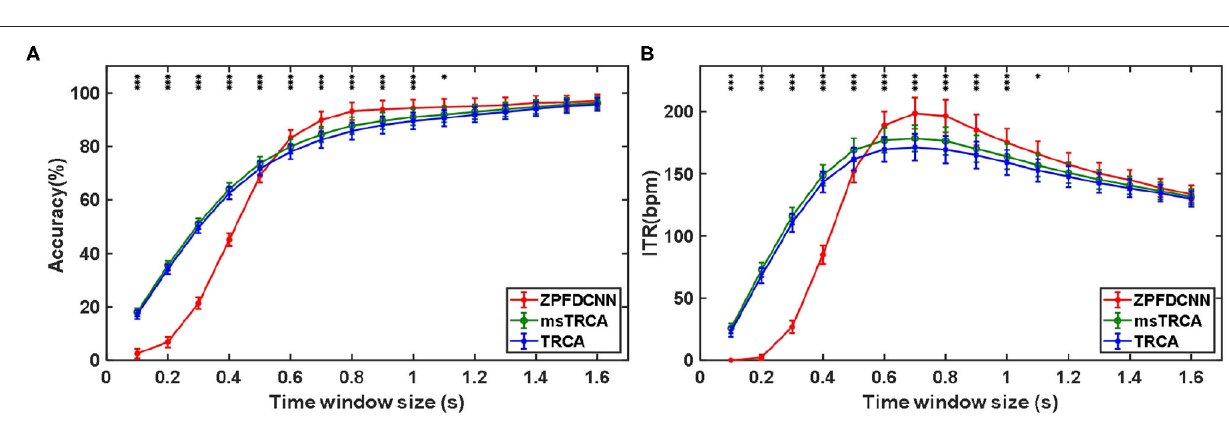
FIGURE 7 | (A) Average classification accuracy of the SSMVEP dataset. (B) The average ITR of the SSMVEP dataset with a visual shift time of 0.55 s. The error bars indicate standard errors. Note that * denotes p < 0.05, ** denotes p < 0.01, *** denotes p < 0.001 according to one-way repeated measure